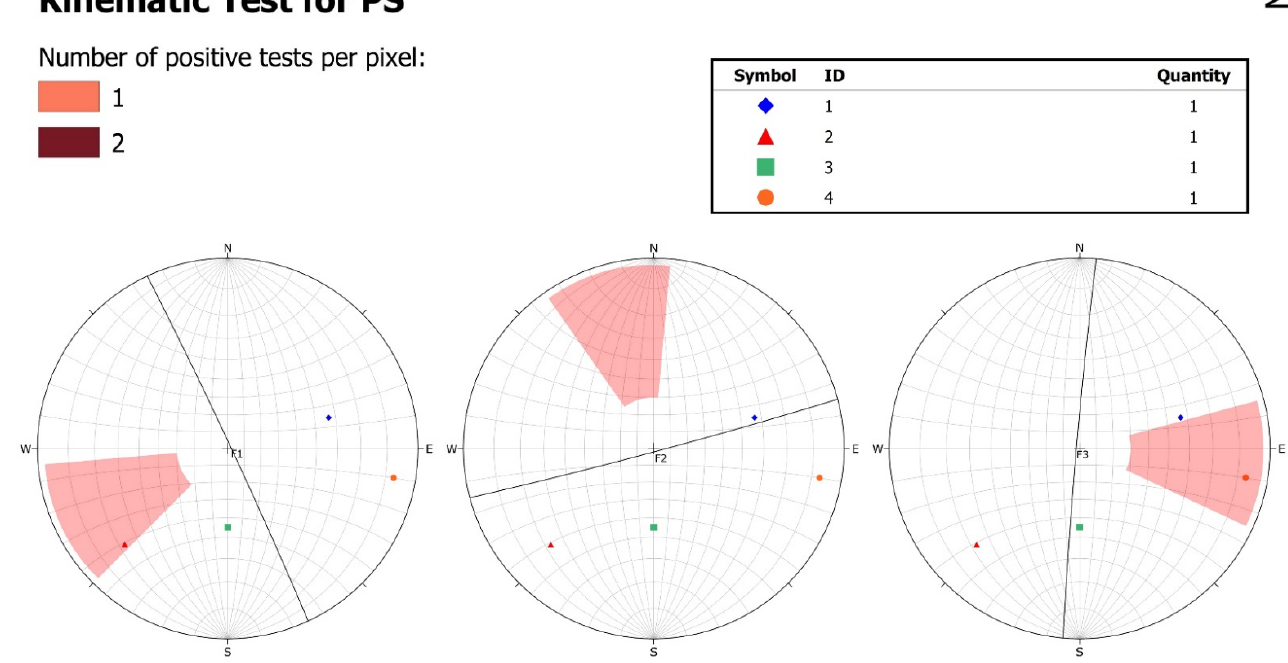
Figure 9. ( above ) Image of the PS sum matrix showing the pixels where the kinematic test for PS is positive: the pixels where there are two positive tests at once are well aligned along the westward exposed surfaces; ( below ) the three traditional stereoplot kinematic tests for PS on the F1 to F3 slope configurations: 7 for F1 the active joint set is K2 (047/73); F2 show no active joint set; for F3, and especially for more eastward exposed surfaces, joint set K4 (280/83) and K1 (253/58) appear active.